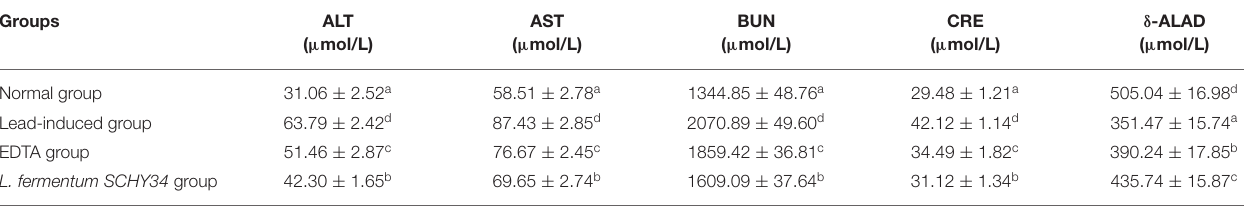
TABLE 6 | ALT, AST, BUN, CRE, and δ -ALAD in the serum of SD rats. Groups